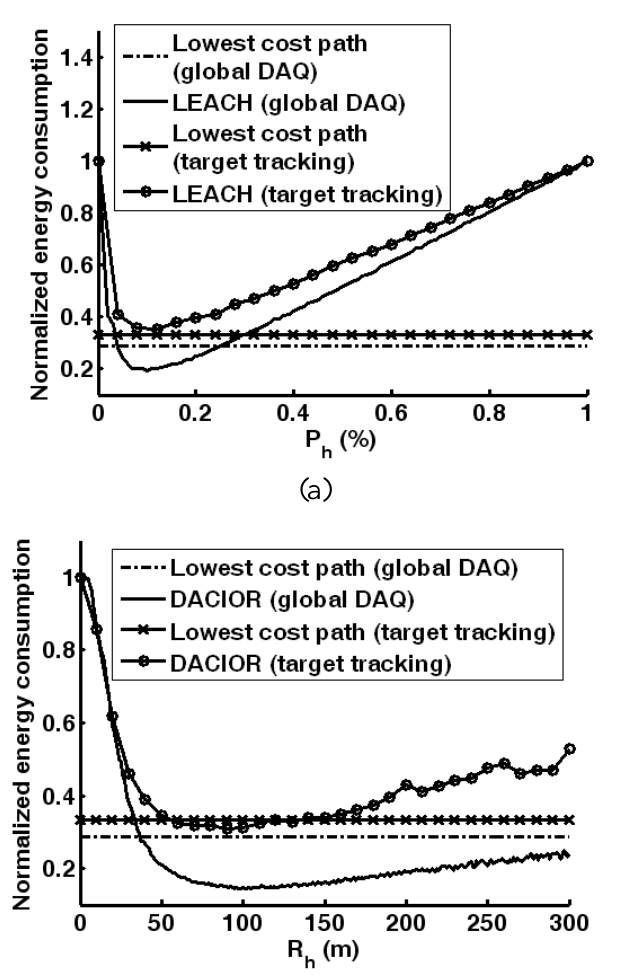
Figure 6. Energy consumption during global DAQ and target tracking: (a) Comparison of lowest cost path and LEACH; (b) Comparison of lowest cost path and